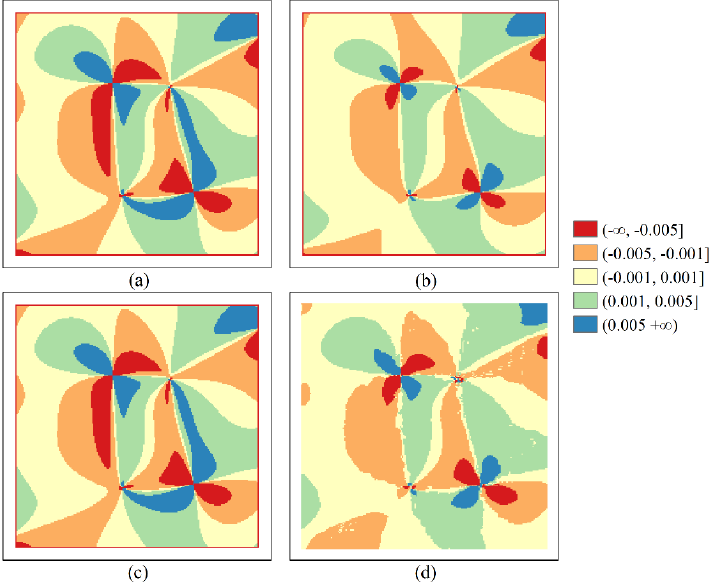
Figure 10. Spatial distribution of the residuals of the simulated C values relative to the theoretical C values on G1 for the: ( a ) Evans, ( b ) Zevenbergen, ( c ) Shary, and ( d ) FPN-based methods.